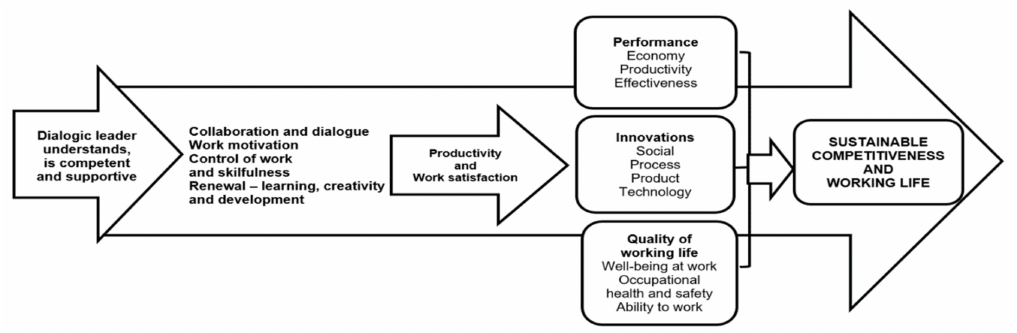
Figure 1. The multidisciplinary framework of dialogic leadership and development (adapted and modified from [12]).